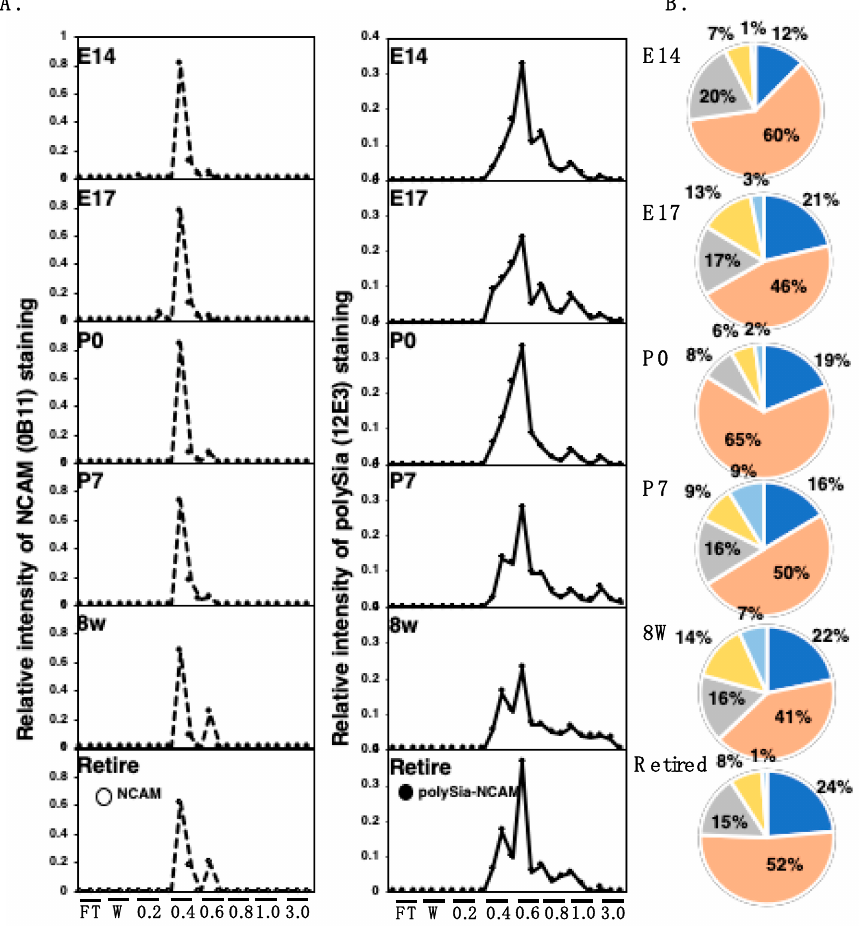
FT W 0.2 0.4 0.6 0.81.0 3.0 Figure 8. Chromatograms of polySia–NCAM and NCAM derived from mouse brains at different developmental stages analyzed by DEAE-Sephadex A-25 anion-exchange chromatography. ( A ) Elution profiles of anion-exchange chromatography of polySia–NCAM. Crude samples (solid line) or samples treated with Endo-N (broken line) were subjected to a DEAE-Sephadex A-25 anion-exchange column (500 μ g as protein). The samples were step-wisely eluted with 1.5 mL of 2 mM Tris-HCl buffer containing 0.1% Triton and NaCl (0.2, 0.4, 0.6, 0.8, 1.0, and 3.0 M). Then, 10 μ L of the sample from each fraction was analyzed by SDS–PAGE/Western blotting. For intact samples, most of the polySia on NCAM was detected by the anti-polySia antibody, 12E3 (right panel), while the Endo-N-treated sample, with only oligo-Sia–NCAM remaining, was detected by the anti-NCAM antibody (left panel). Flow-through (FT) fractions and wash buffer were composed of only 0.1% Triton and 2 mM Tris-HCl with 0.15 M NaCl. The sum of all fraction intensities detected by Western blotting was set to 1.0. ( B ) Comparison of the distribution of negative charges of the polySia–NCAM among brains at different developmental stages. The pie charts were described according to the chromatograms of anion-exchange chromatography of the crude sample. The intensity of 12E3 staining from each of the indicated NaCl concentrations was summed and the accumulation of the intensities of all lanes detected by Western blotting was set to 100%. Blue, pink, grey, yellow, and sky blue were 0.4 M, 0.6 M, 0.8 M, 1.0 M, and 3.0 M, respectively.